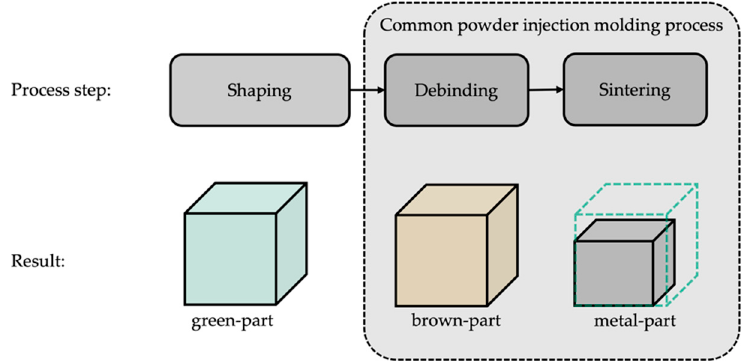
Figure 1. Schematic overview of the metEBAM process. The color scheme introduced for the parts will be used consistently in all figures below.